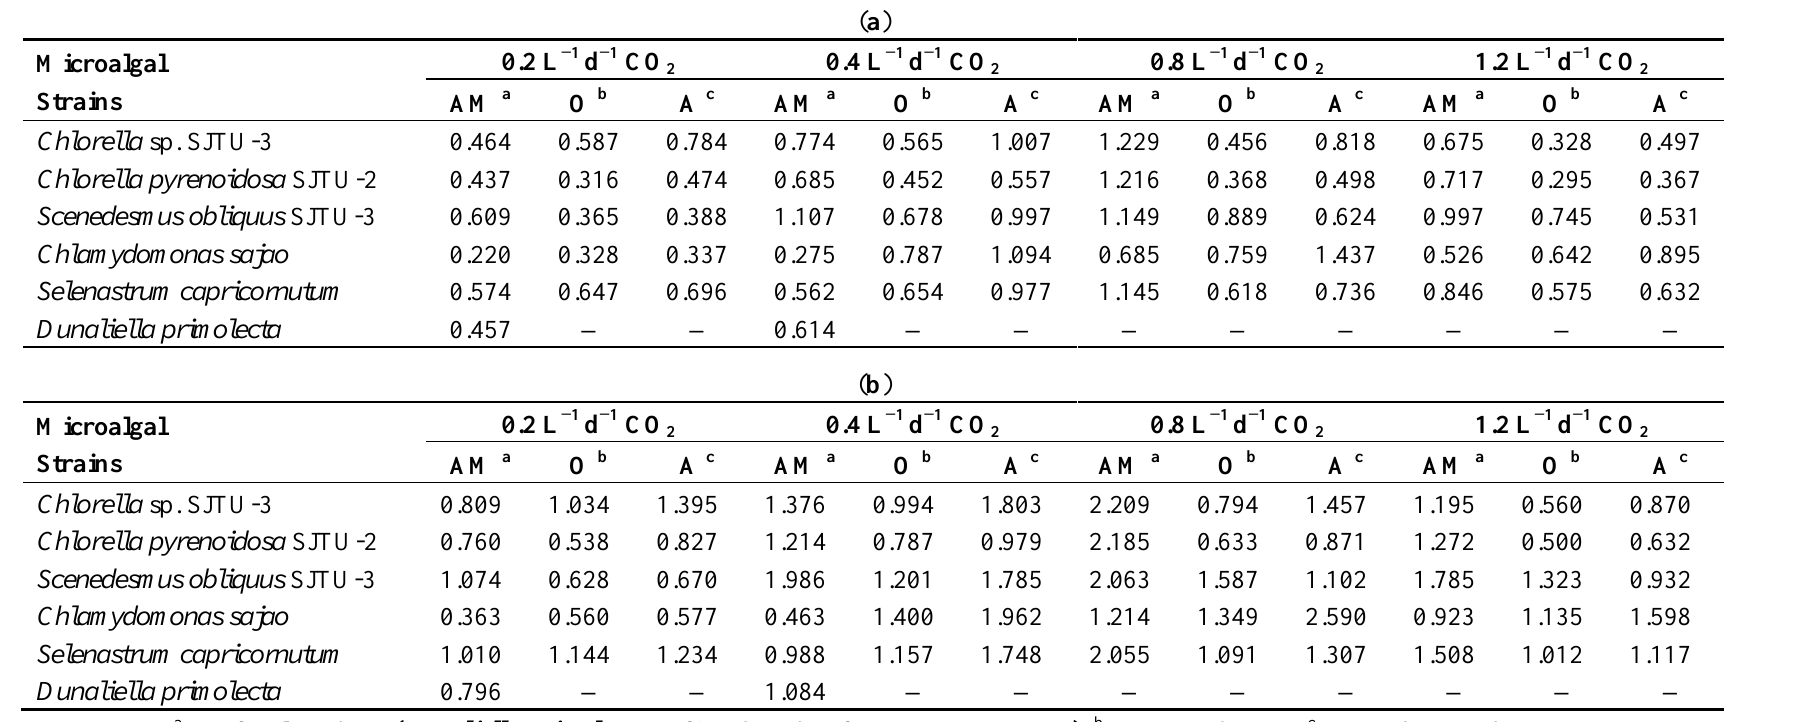
Table 3. ( a ) Cell density (g L −1 ) of 6 microalgal cultures in different media with different CO in M96SS; ( b ) CO fixation (g L −1 ) of 6 microalgal cultures in different media with different CO 2 in